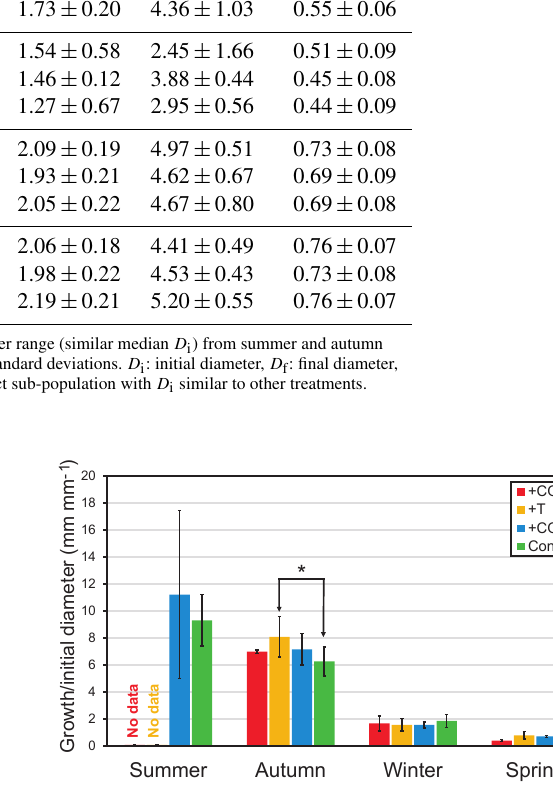
Figure 14. Average growth (Gr /D i ) in different treatments during seasonal experiments. In autumn, growth differed significantly be- tween the + T and control treatments. The effect is only significant in the small sub-population, while the autumn-big sub-population showed no significant temperature effect. However, the small sub- population dominates the autumn population. Thus the total popu- lation shows a significant temperature effect. In summer, no tubes were recovered from the elevated temperature treatments. Results from three-way ANOVA and Tukey’s HSD tests; ∗ significant dif- ference ( p < 0 .